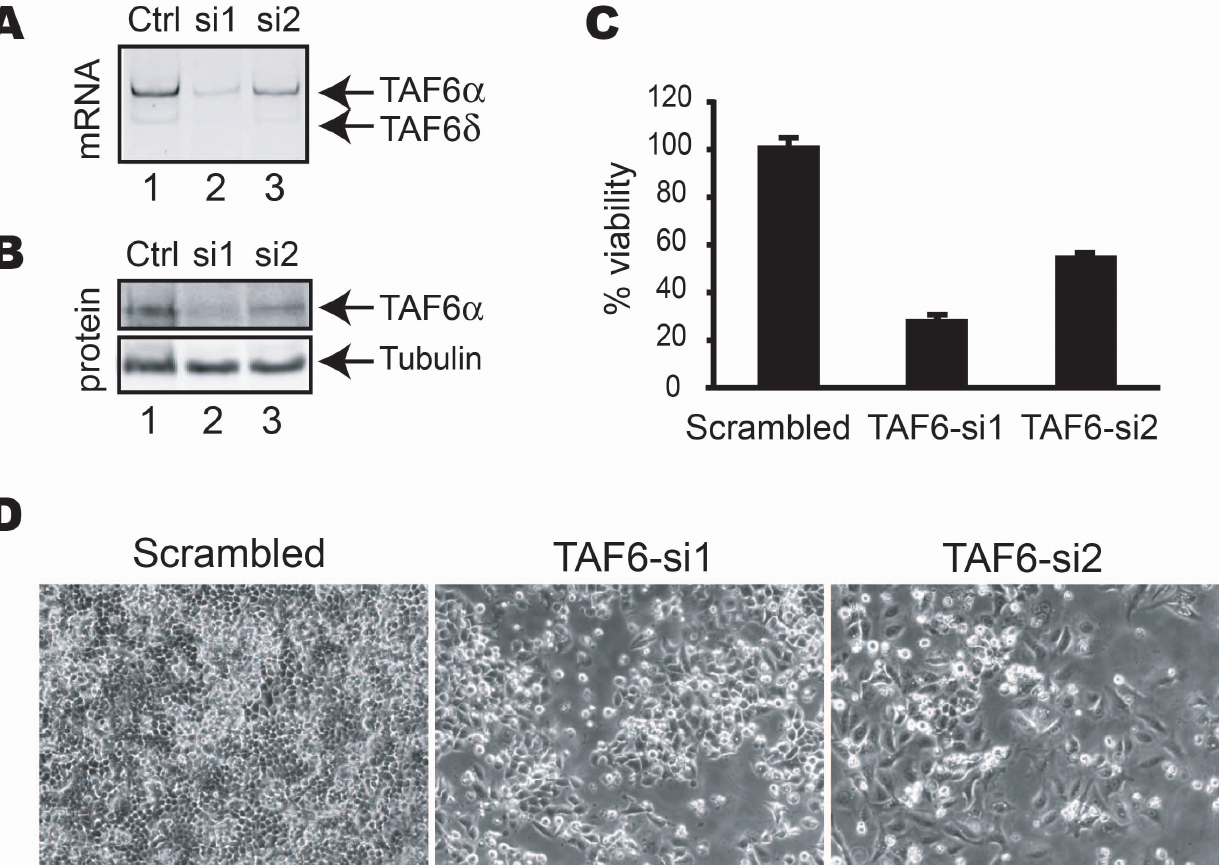
Figure 1. TAF6 is essential for human cell viability. (A) PCR analysis of TAF6 mRNA levels 72 hours post-transfection with siRNAs targeting all TAF6 mRNAs. (B) Total cell extracts from HeLa cells transfected with the indicated siRNAs for 72 hours were separated by SDS-PAGE subject to Western blot analysis with monoclonal antibodies specific for TAF6 a and tubulin as a loading control. (C) The viability of HeLa cells transfected with siRNA directed against TAF6 was measured 4 days post-transfection by methylene blue staining (see materials and methods). Viability (y-axis) is expressed relative to that of cells transfected with control siRNA. (D) TAF6 depletion results in loss of HeLa cell viability. HeLa cells were treated for 4 days with control siRNA (panel 1), or siRNA that target the TAF6 mRNA (panels 2 & 3). Cells were photographed with a phase-contrast